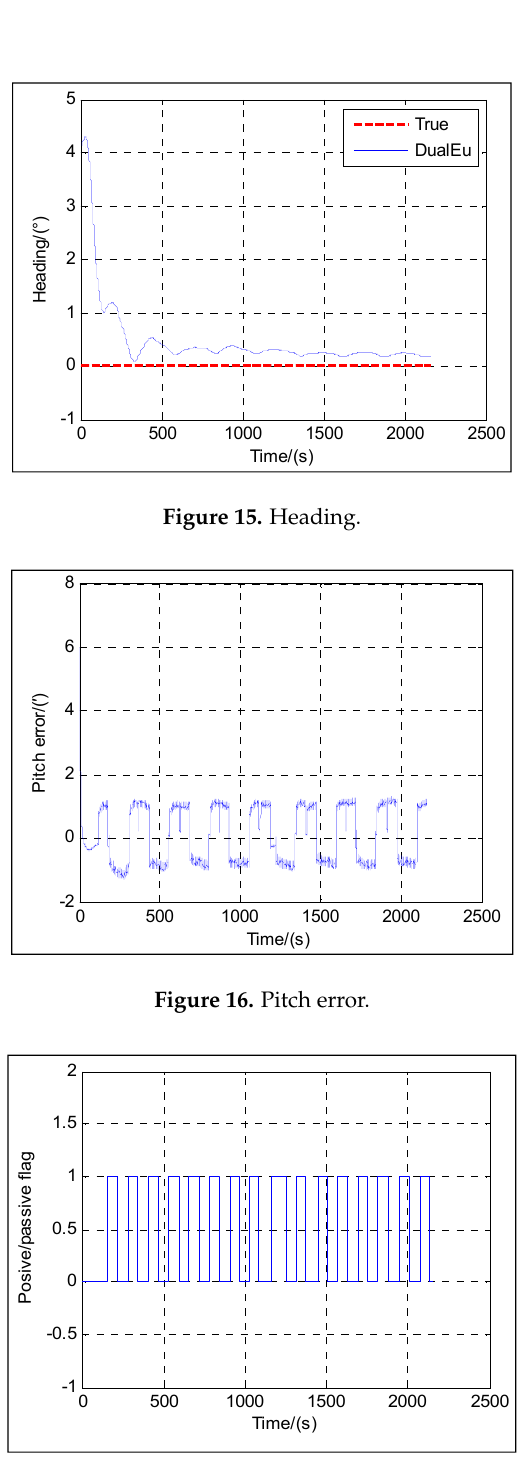
Figure 17. Switch flag.